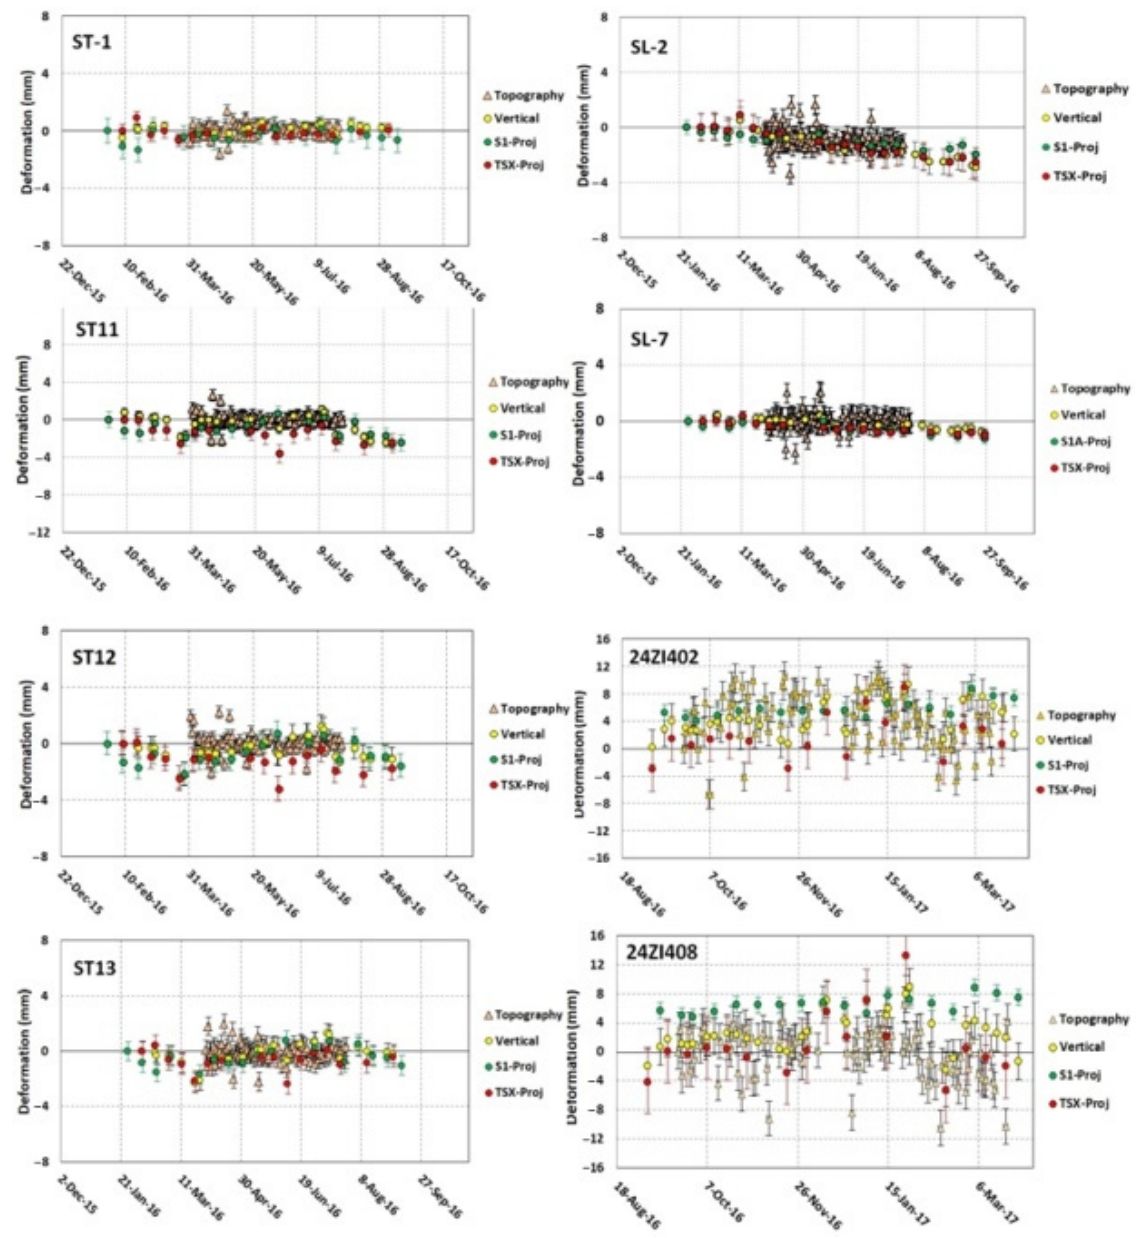
Figure 9. Vertical ground deformation of the prisms locations (MP projected and MP decomposed) and TS (vertical topographic measurements): ST-1; ST-11; ST-12; ST-13, SL-2; SL-7; 24ZI402; 24ZI408. The vertical MPs values obtained by S1-Proj, TSX-Proj and decomposed showed sim- ilar results for ST-1, ST11, ST12, ST13, SL-2 and SL7 prisms, with SL-2 presenting a slight tendency to